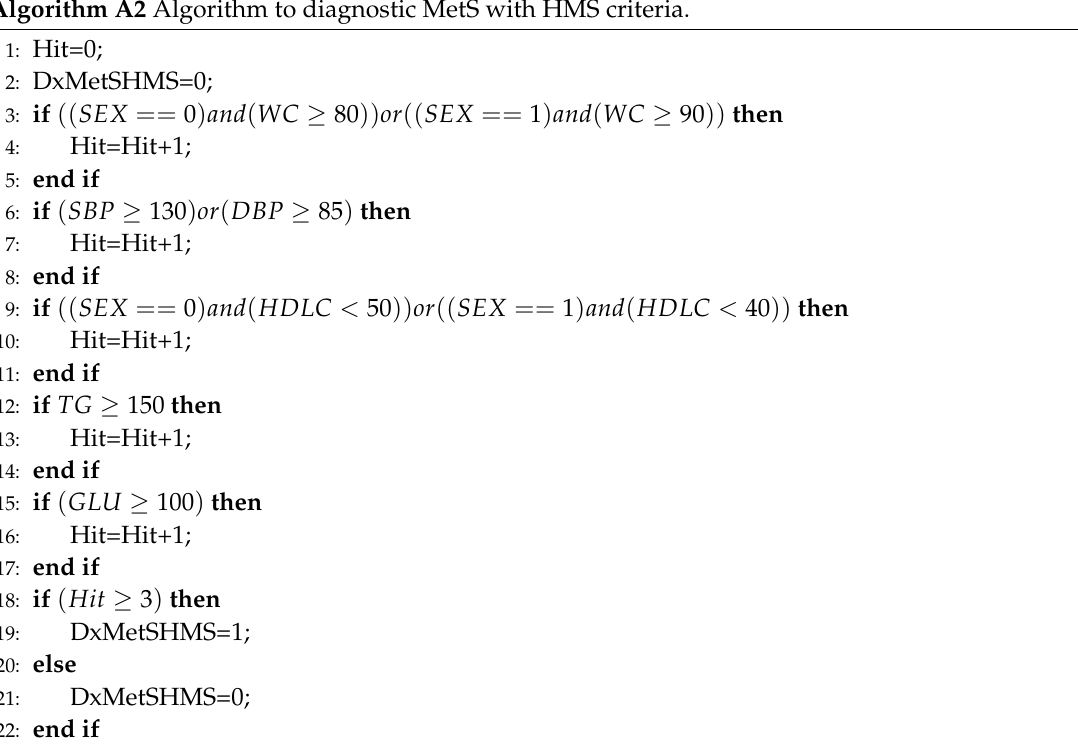
Algorithm A2 Algorithm to diagnostic MetS with HMS